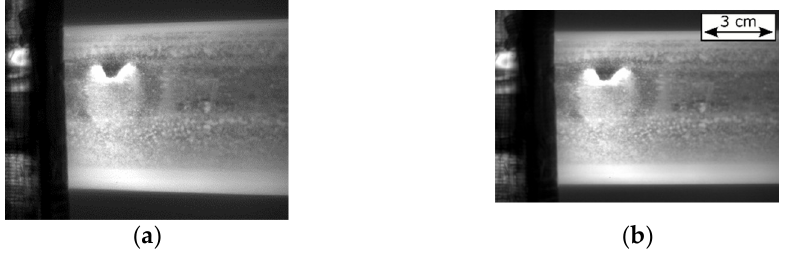
Figure 11. ( a ) IR image of the squat defect during scanning, inductor is visible on the left side; ( b ) image after applied rectification transformation.